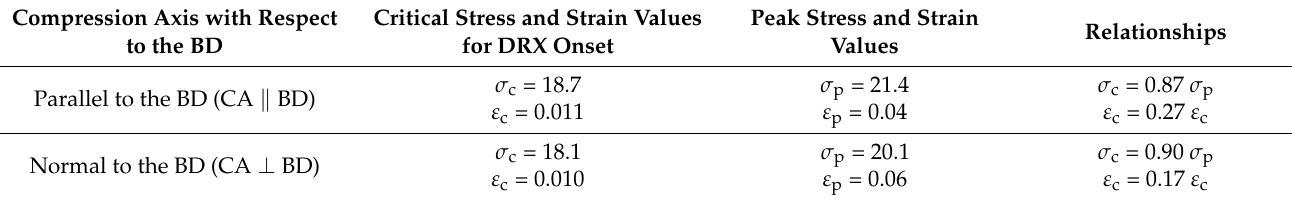
Table 1. Critical stress and strain values for the onset of DRX in the samples deformed in different directions to the BD and their relationships with peak stress and strain ( σ c / ε c —critical stress and strain for the initiation of DRX, σ p / ε p —peak stress and strain). CA and BD are the compression axis and building direction during LPBF. The measurement accuracy is around ± 0.3